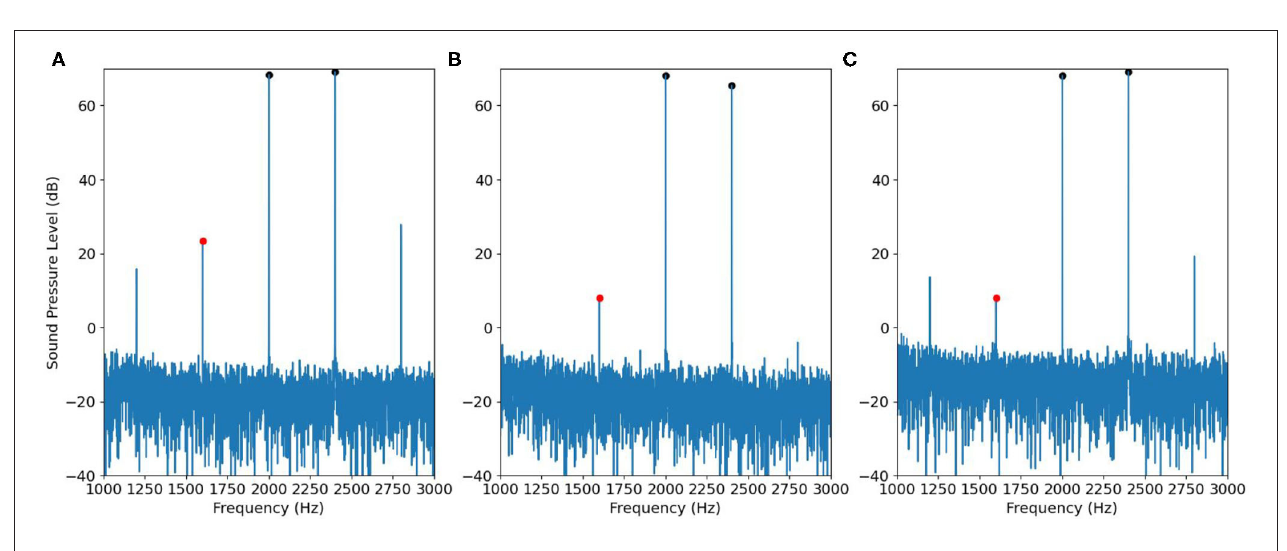
FIGURE 11 | Similar to Figure 10 , but with f 1 = 2,000